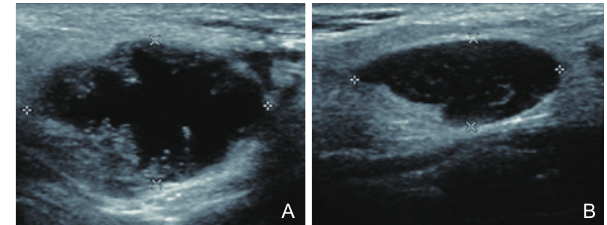
Figure 1 US evaluation before MWA. (A, B) Longitudinal ultrasound images showed that there was a mix nodule of 2.7cm×1.6cm ×1.5cm in the right parotid gland and 2.3cm×1.2cm ×1.0cm in the left side, with regular shape and clear boundary.